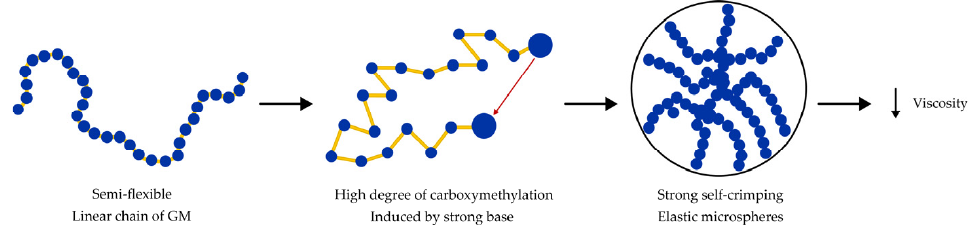
Figure 7. Effect of carboxymethylation on the structure of GM.